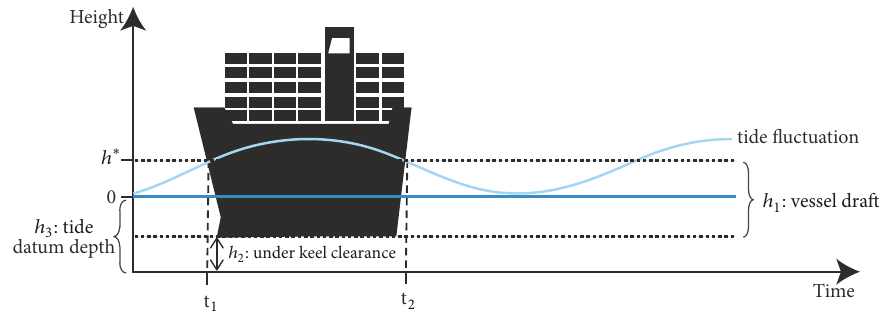
Figure 1: Illustration of a vessel passing through the approach